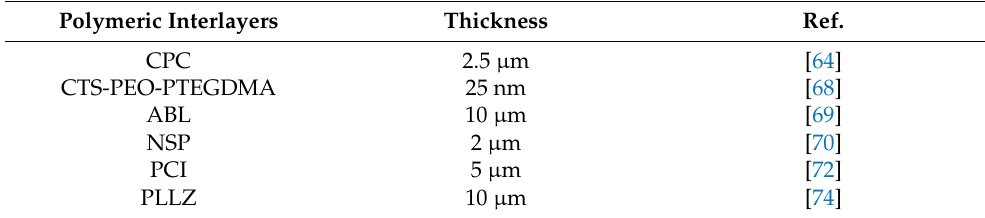
Table 1. Summary of polymer interlayer thicknesses in reported